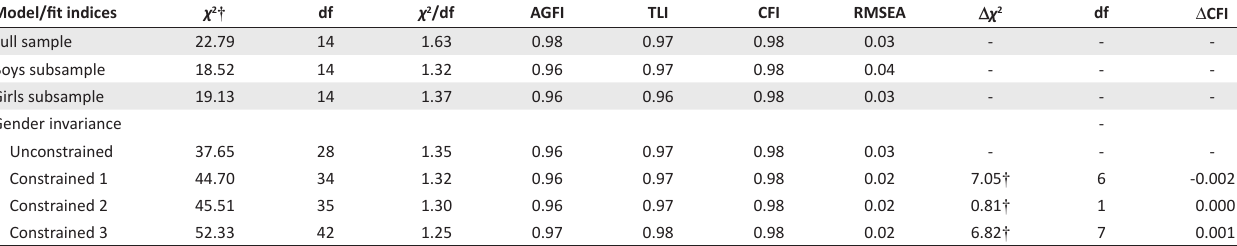
TABLE 1: Fit statistics for the Generalised Anxiety Disorder-7 scale in adolescents . Model/fit indices